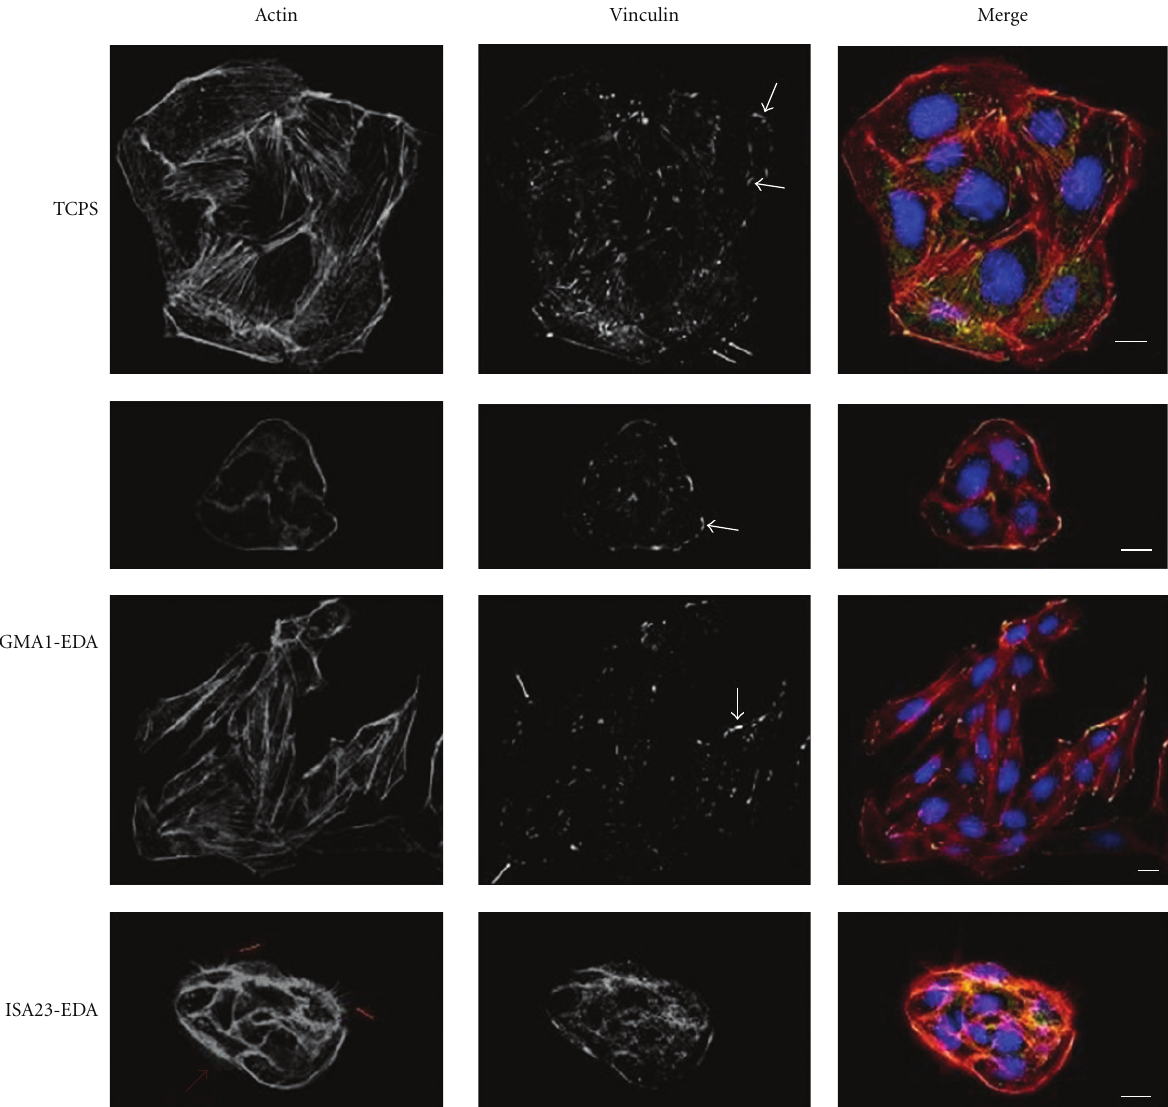
Figure 8: Immunofluorescence analysis of actin cytoskeleton and focal contacts of TCPS or hydrogel MDCK growing cells [62].